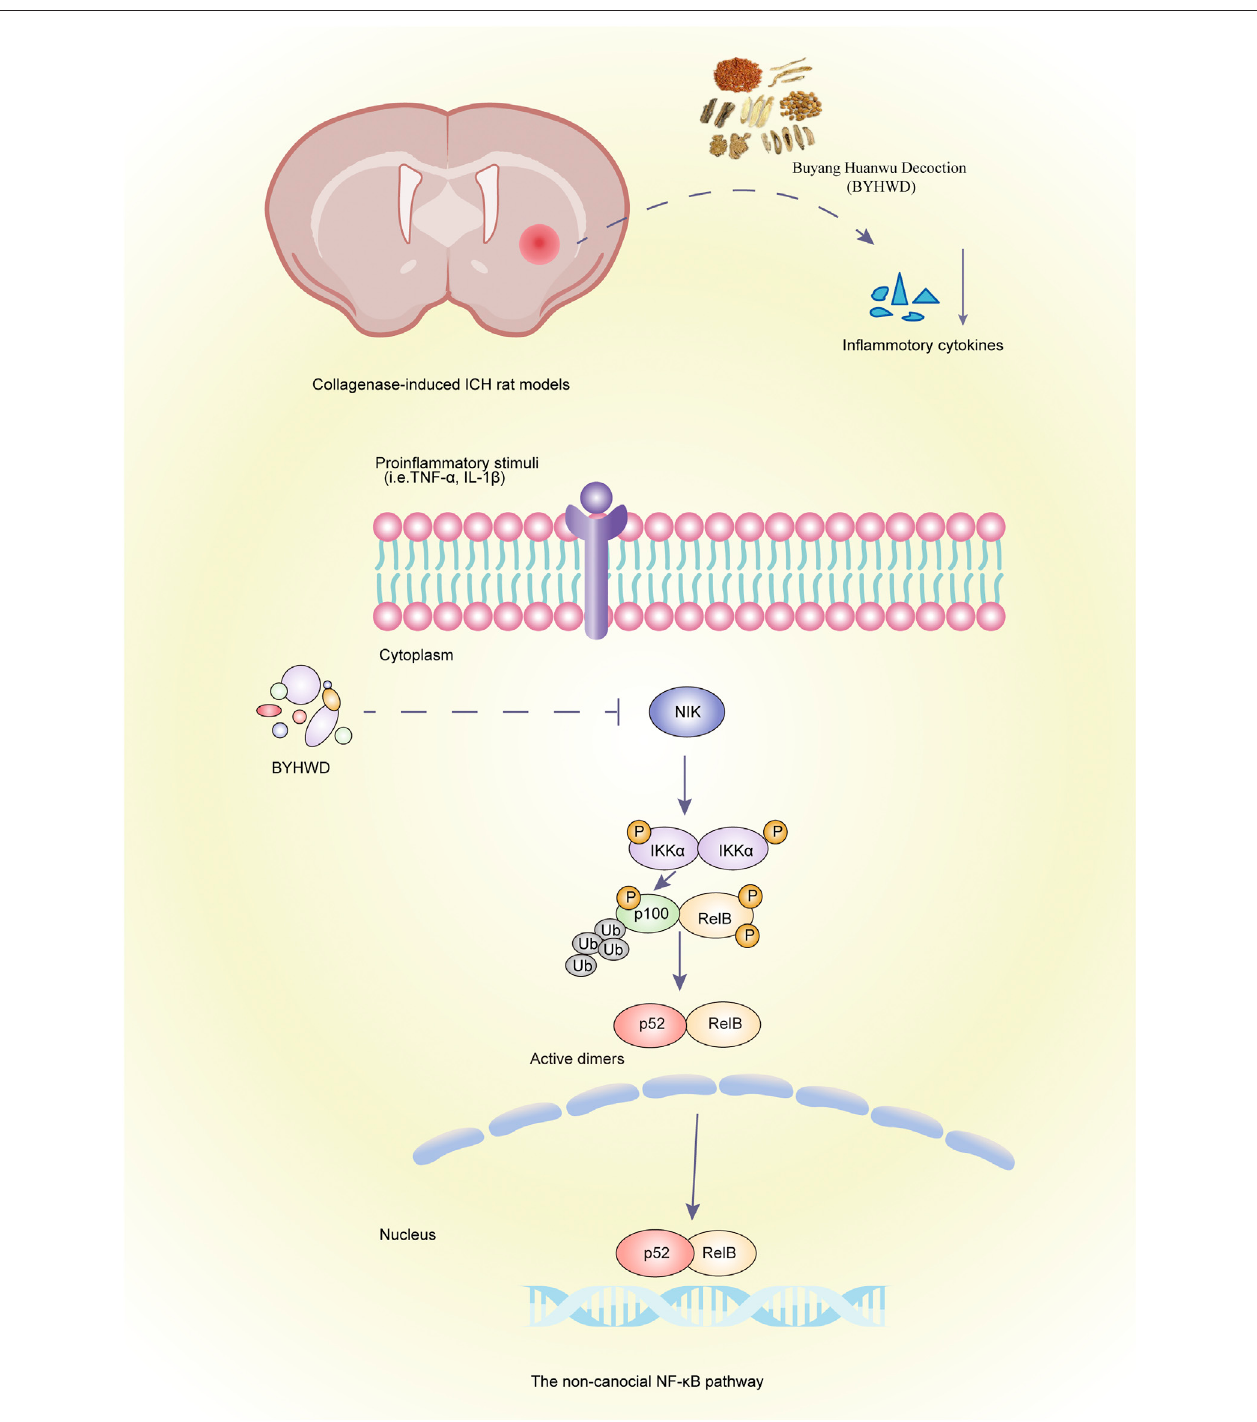
FIGURE6| Graphicabstract.SchematicofBYHWDattenuatethein fl ammatoryresponsebyinhibitingthenoncanonicalNF- κ Bpathway via downregulationofNIK at the recovery phase of ICH in a rat model.